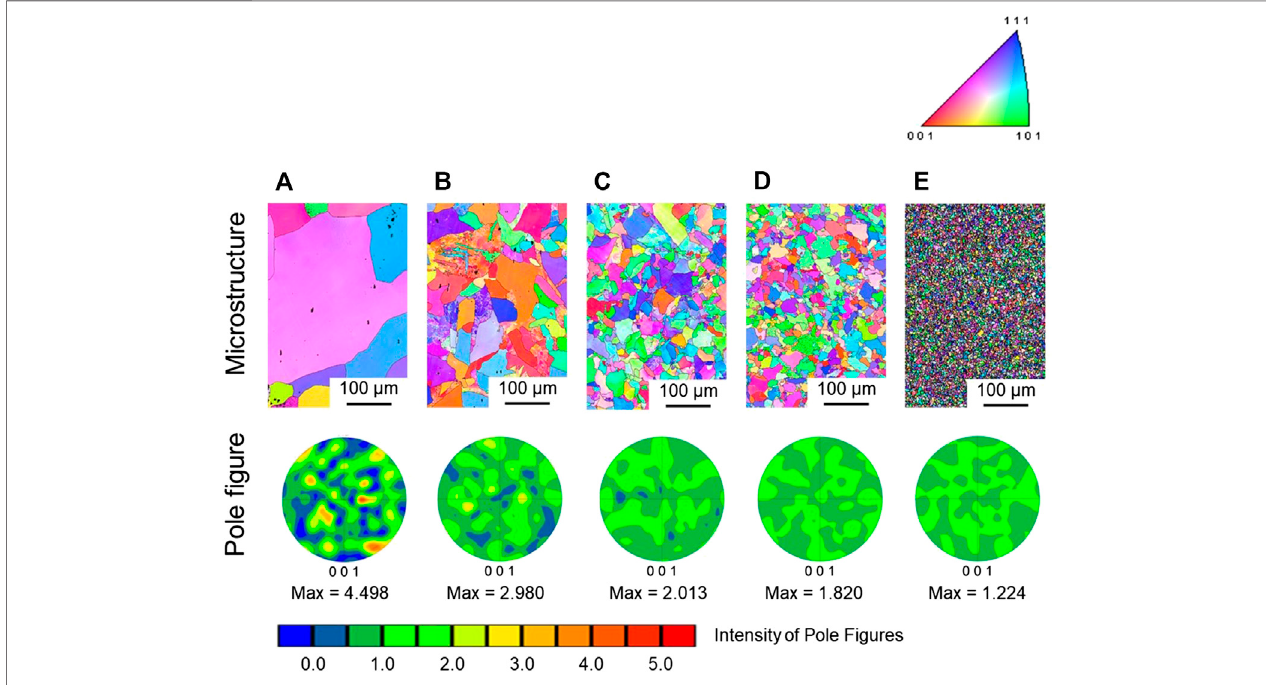
FIGURE 6 | EBSD orientation color maps and corresponding 001 pole fi gures of the specimens simply austenitized at (A) 1,100 ° C, (B) 950 ° C, (C) 900 ° C, and (D) 830 ° C for 6 h followed by furnace-cooling, and the specimen (E) cyclic heat-treated at 810 ° C up to four cycles followed by air-cooling.